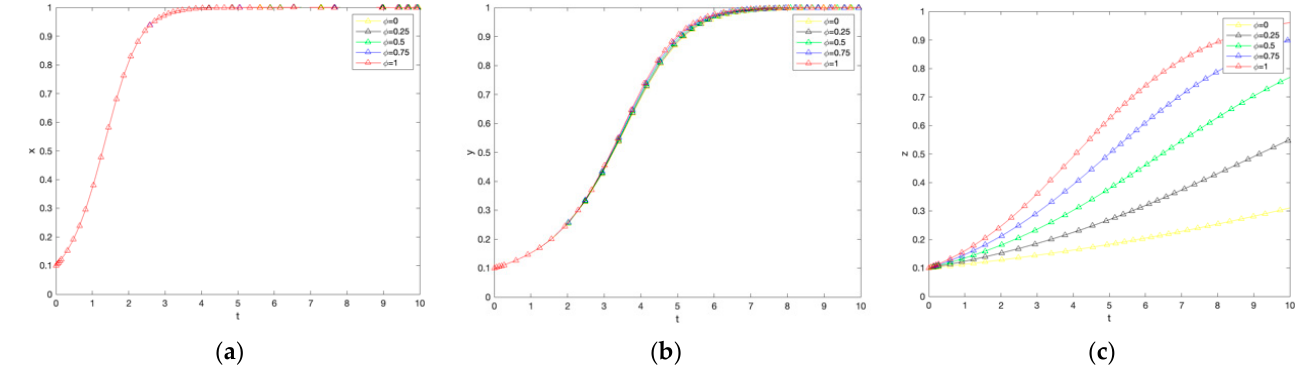
Figure 6. The impact of changes in the additional income coefficient on government subsidies, farmer adoption, and consumer purchases. ( a ) Government response. ( b ) Farmers’ response. ( c ) Consumer reaction.